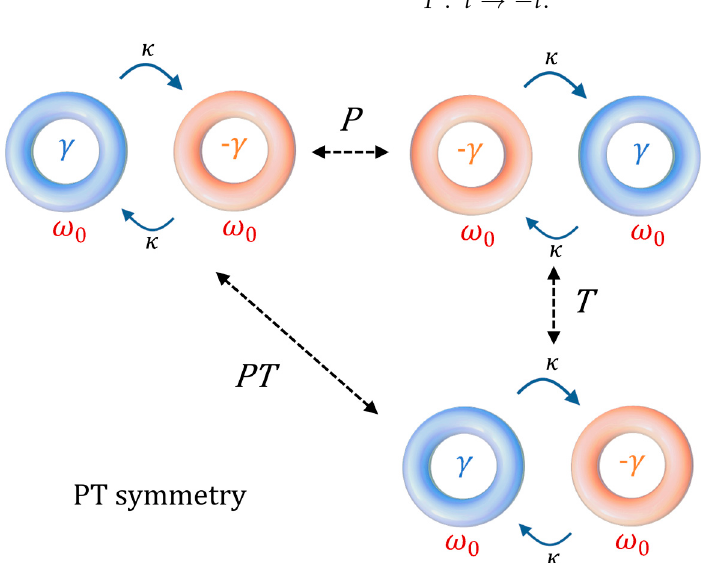
Figure 1. Graphical interpretation of PT symmetry in coupled resonators: γ represents the loss term, ω 0 is the resonant frequency of each resonator, and κ is the coupling strength between the resonators. The system is invariant under simultaneous applications of the parity and time operations.